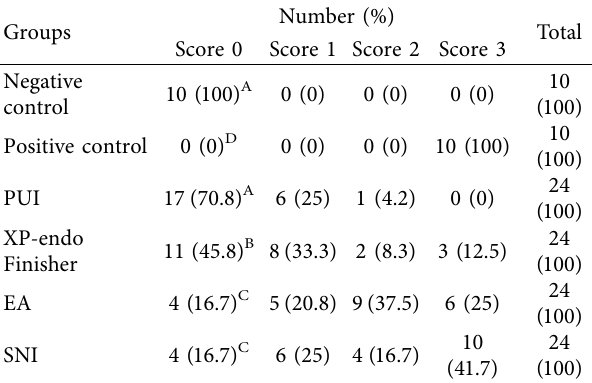
Figure 4: Score 3. The complete cavity is filled with CH remnants (e.g., in the positive control group). Table 1: Comparison of removal efficacy between CH removal methods in group